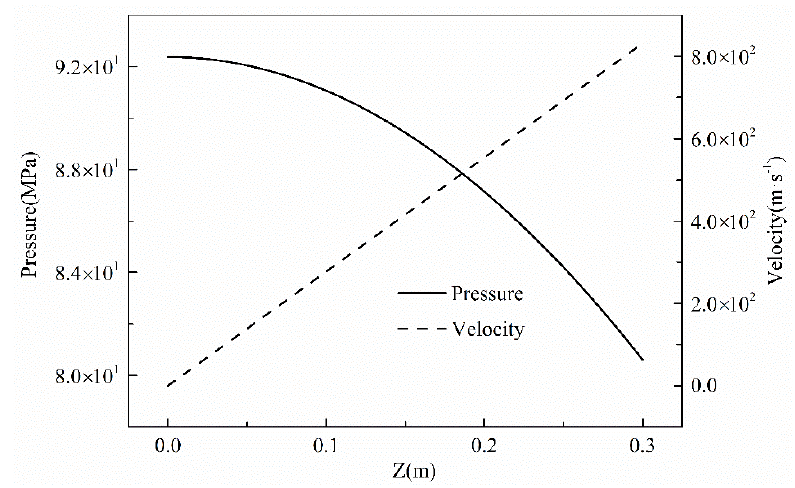
Figure 4. Initial conditions.